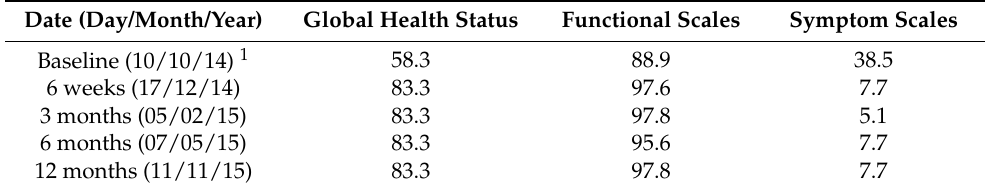
Table 3. Quality of life score measured using the EORTC